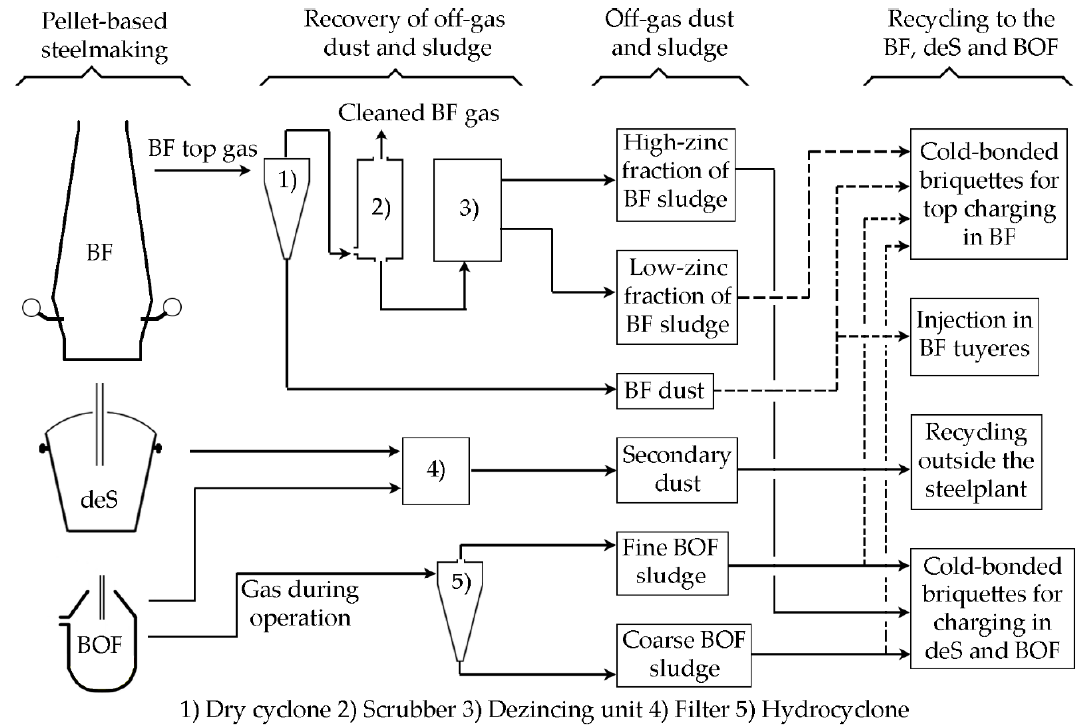
Figure 8. Illustration of the holistic view on recycling of off-gas dust within the integrated steel plant.